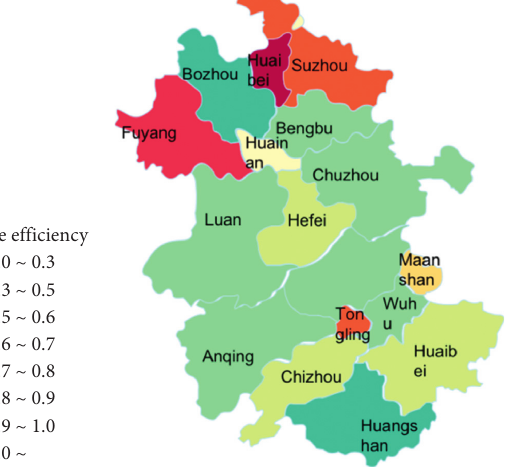
Figure 9: Scale efficiency